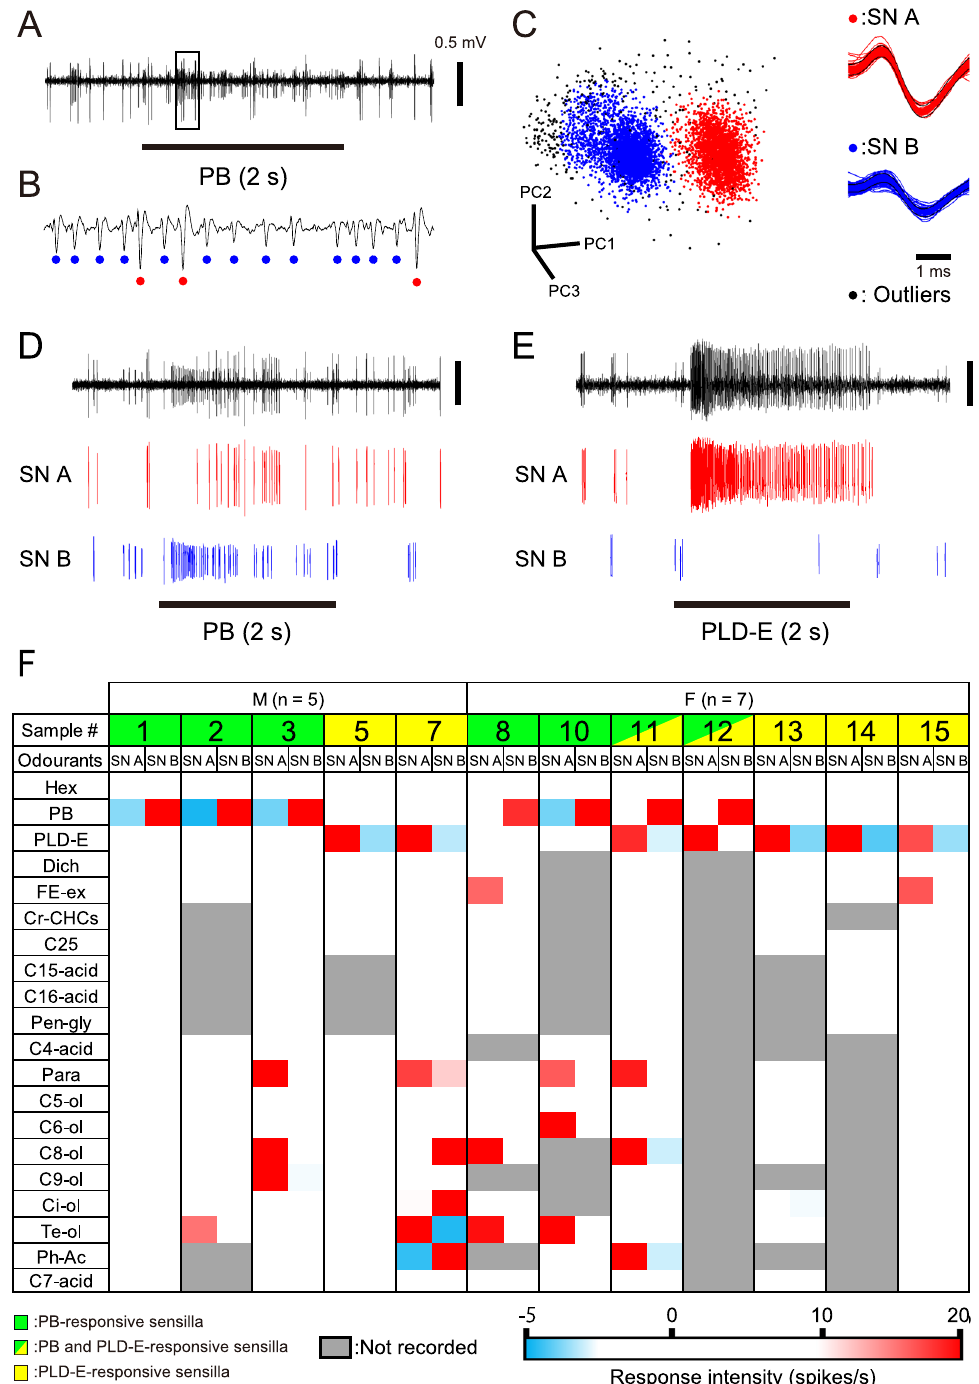
Figure 3. Olfactory responses of OSNs in single pheromone-responsive sw- A2 sensilla. ( A ) The response of a sw- A2 sensillum to PB. ( B ) Expanded electrophysiological trace shown in A. The trace shows small-amplitude spikes (blue dots) and large-amplitude spikes (red dots). ( C ) Identification of two OSNs in single sw- A2 sensilla. Each of spikes is plotted based on the first three principal components (PC1-PC3) obtained from the principal component analysis using the spike amplitudes and durations (left). Cluster analysis identified two groups of spikes (red and blue dots). Outliers of the cluster analysis are shown as black dots in the 3D-space and removed from the subsequent analyses. The spike waveforms of red and blue dots are superimposed (right), and large- amplitude spikes of SN A and small-amplitude spikes of SN B are denoted by red and blue colours, respectively. ( D , E ) Segregated activities of SN A and SN B in PB-responsive (D) and PLD-E-responsive sw- A2 sensilla (E). ( F ) Olfactory responses of SN A and SN B to the tested odourants. We selected 12 pheromone-responsive sw - A2 sensilla from our SSRs (sample numbers in F and Fig. 2D) and sorted spikes of SN A and SN B. M: male, F: